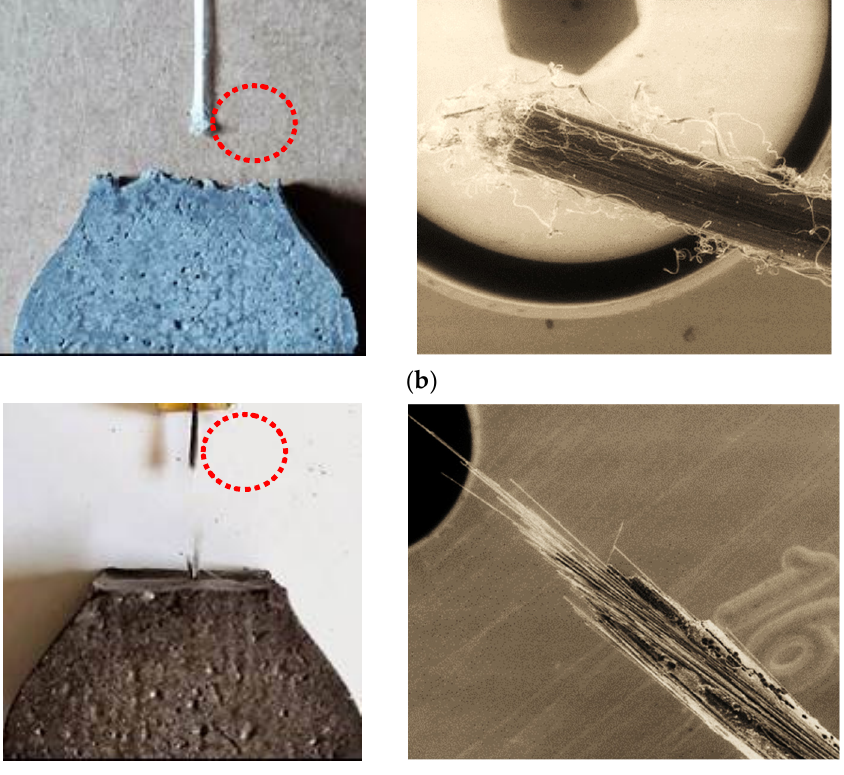
Figure 4. SEM images of fiber after being pulled out: ( a ) SF, ( b ) PF, and ( c )